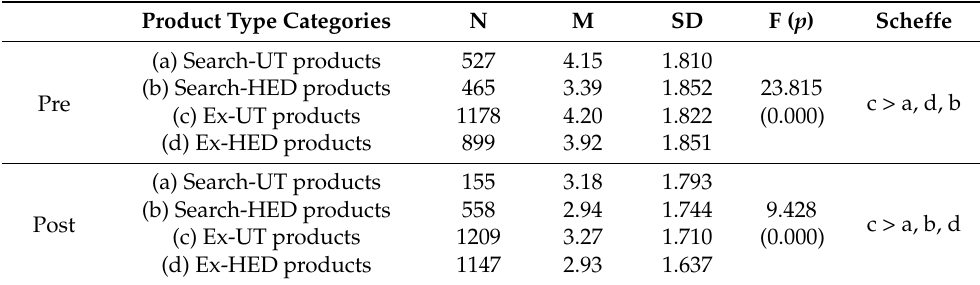
Table 13. One-way ANOVA results of purchase intention by product type category for the